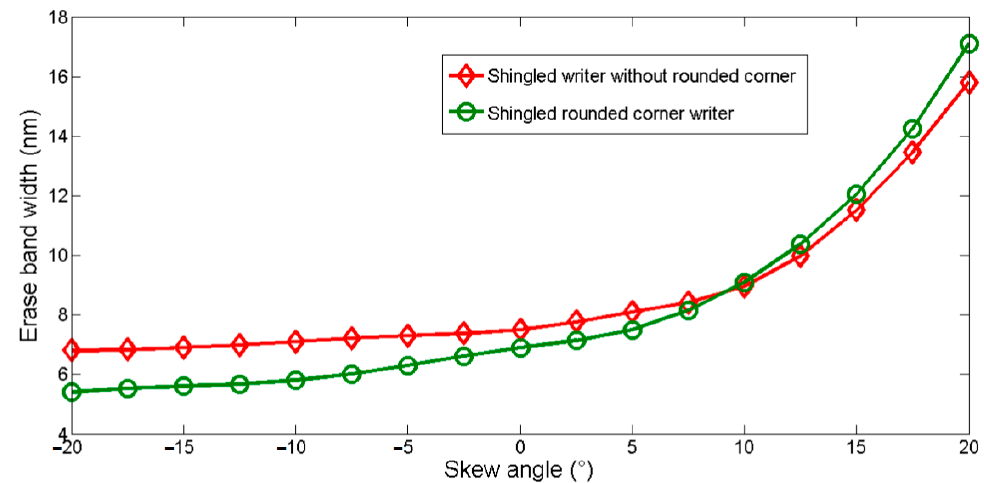
Figure 7. Comparison of the skew angle dependence of EBW between shingled writer without rounded corner and shingled rounded corner writer (with θ = 40° and L = 3 nm).